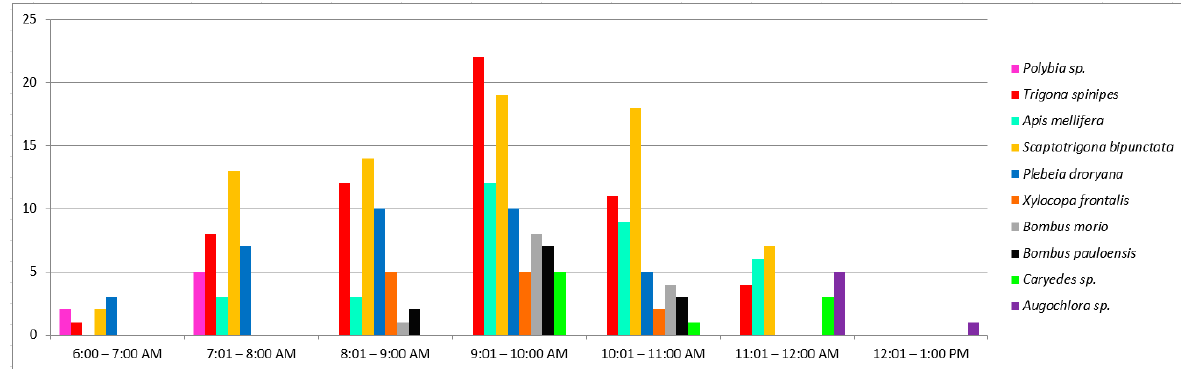
Figure 5. Number of species interactions in one-hour intervals during anthesis of Pereskia aculeata in Porto Alegre Botanical Garden (10 mornings).